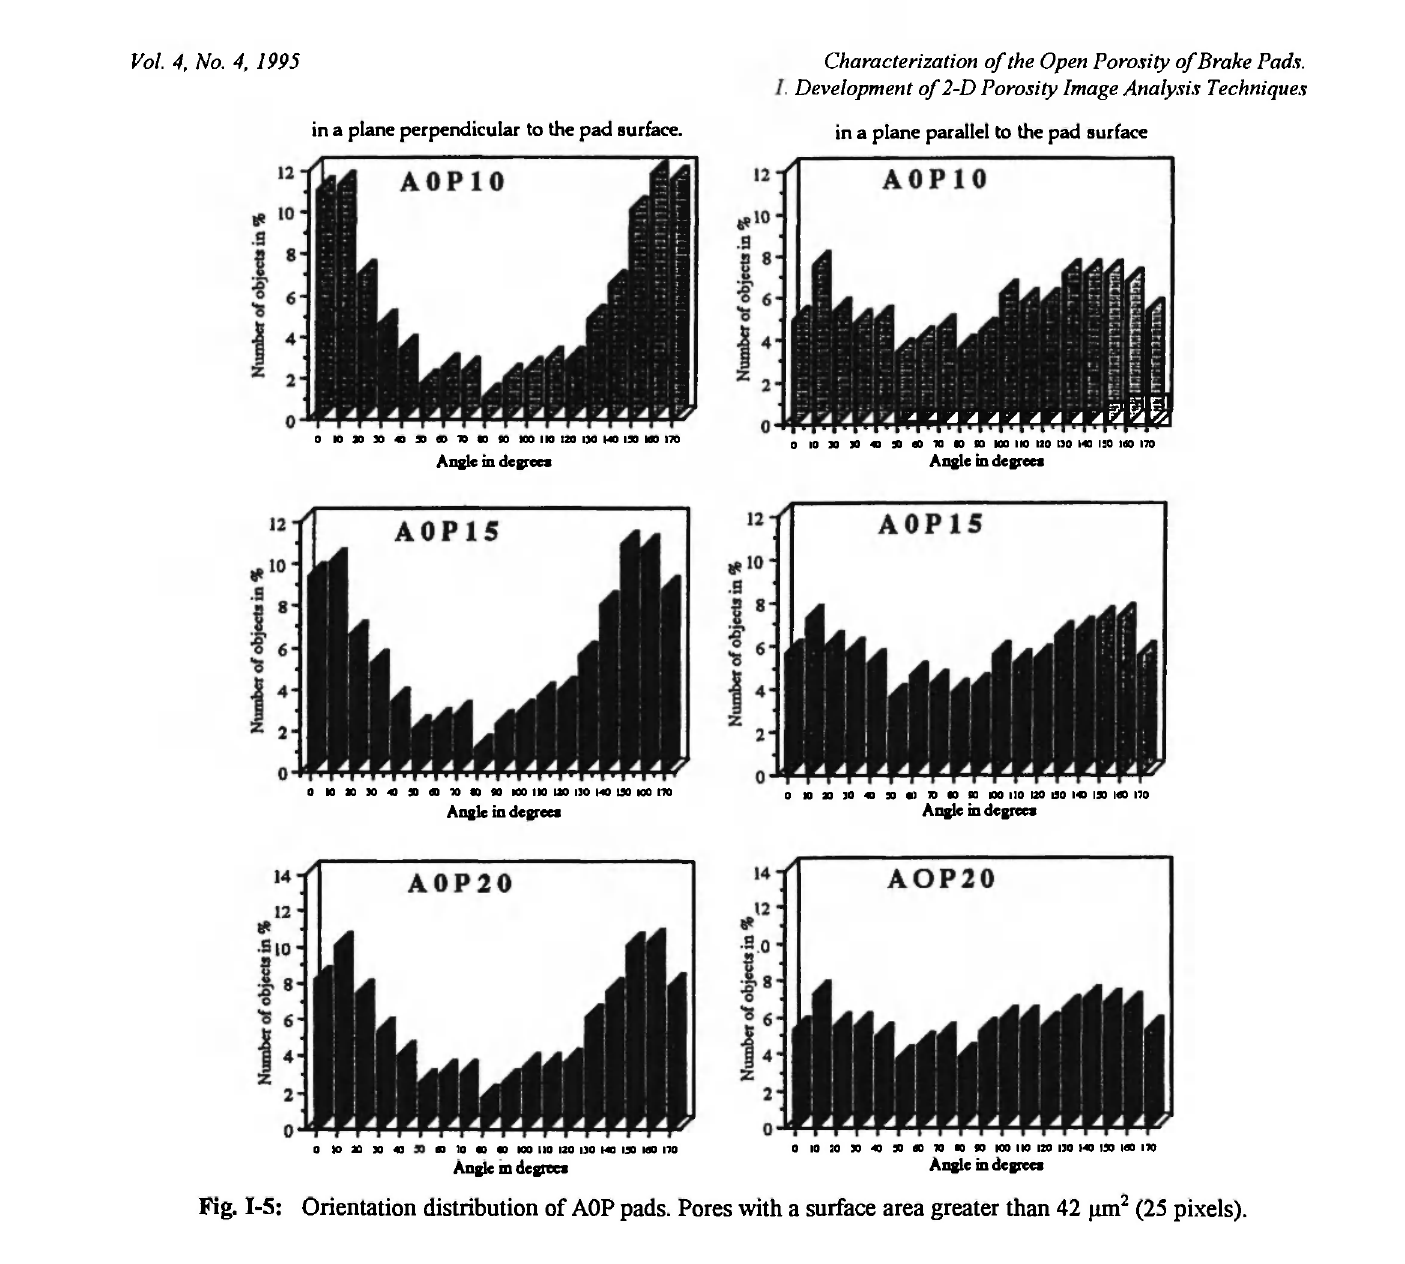
copper and zinc creates a local increase in background noise by modifying the radiation due to bremstrahlung /7,8/. Since the background noise had been corrected on the average for all points of the surface analyzed, the excessive background noise on the brass suggests the presence of